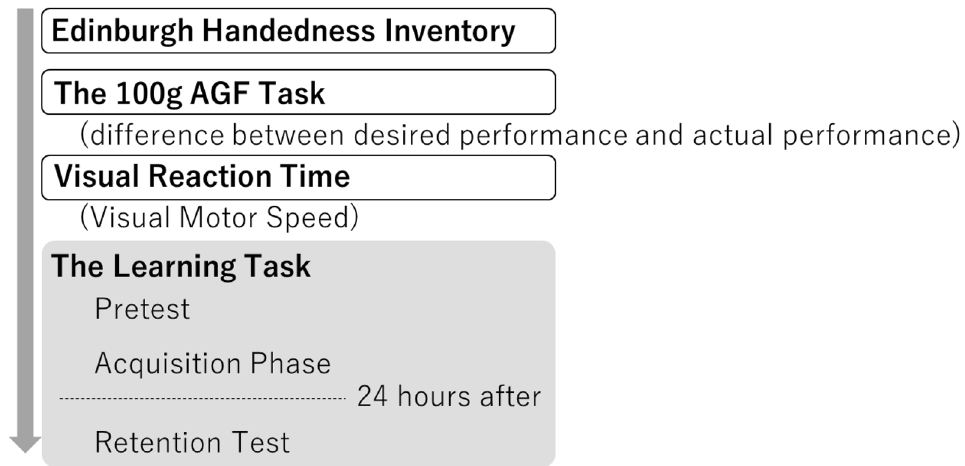
Figure 2. Procedure. In the 100 g AGF task, 5 trials were performed without giving feedback. The number of VRT measurements was 5 trials. Regarding the main learning task, the pre-test was conducted in 4 trials without feedback. The acquisition phase consisted of 4 trials × 3 blocks for a total of 12 trials, and concurrent feedback was given during the performance. The retention test was conducted about 24 h after the acquisition phase in the same manner as the pre-test.